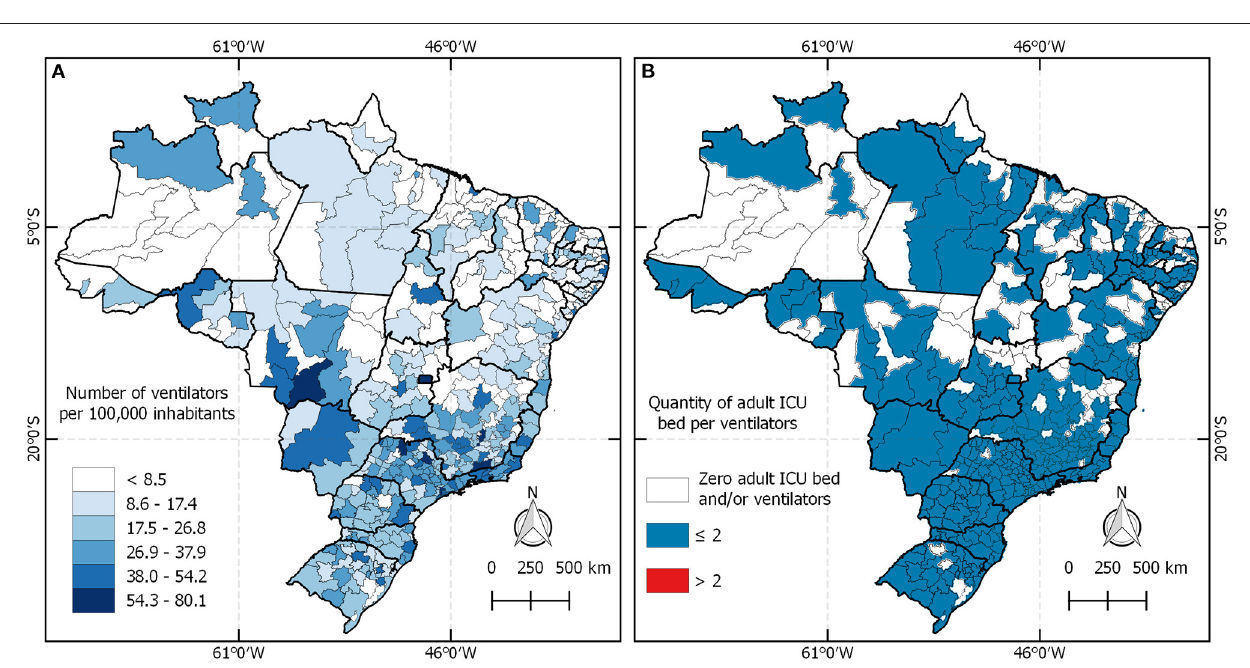
Frontiers in Public Health |